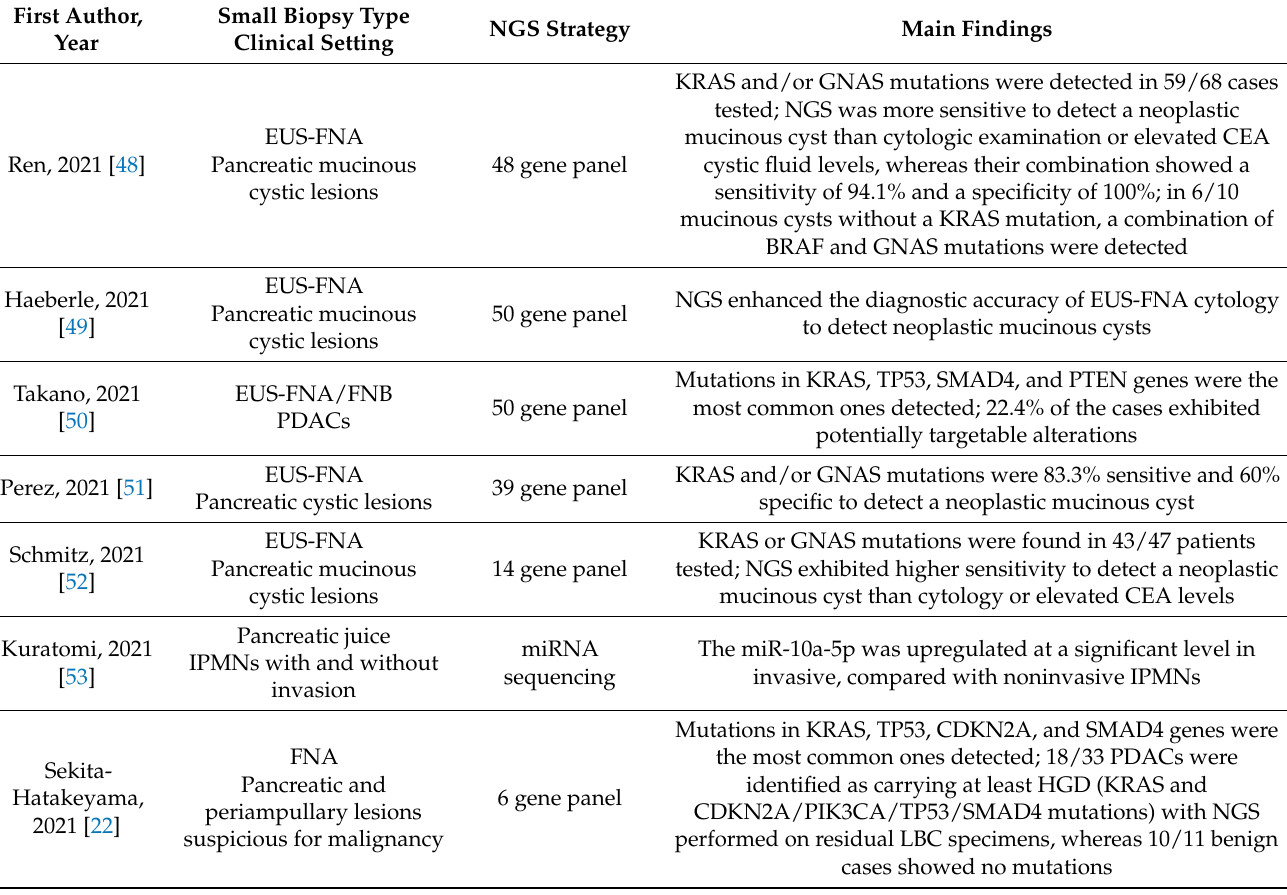
Table 1. The role of NGS performed on pancreatic small biopsies (EUS-FNA and FNB, brushings, and pancreatic juice): doing more with